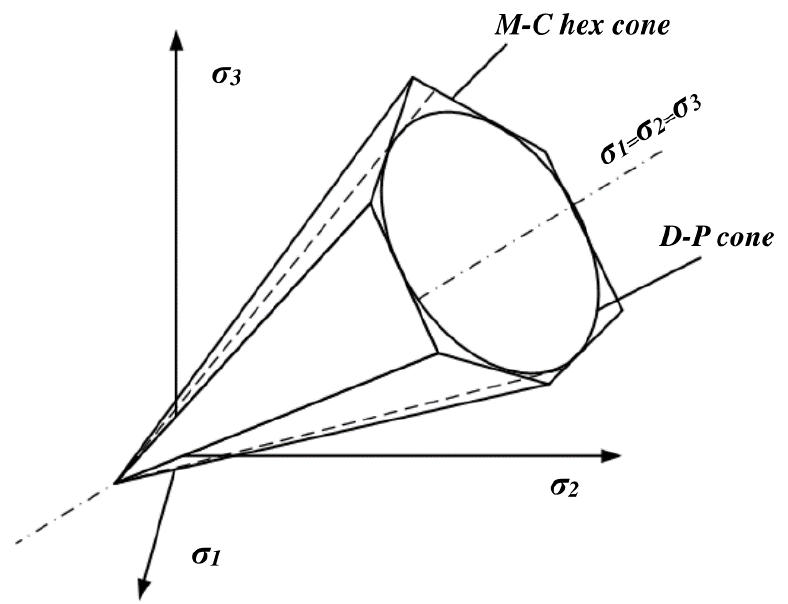
Figure 4. A comparison between the three-dimensional failure surface derived from the M-C criterion and the D-P